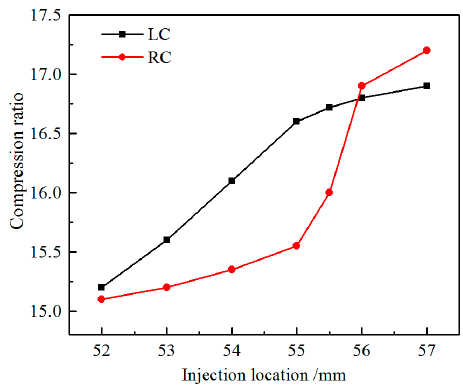
Figure 9. Compression ratio variation of LC and RC for different values of the “triggering position”.